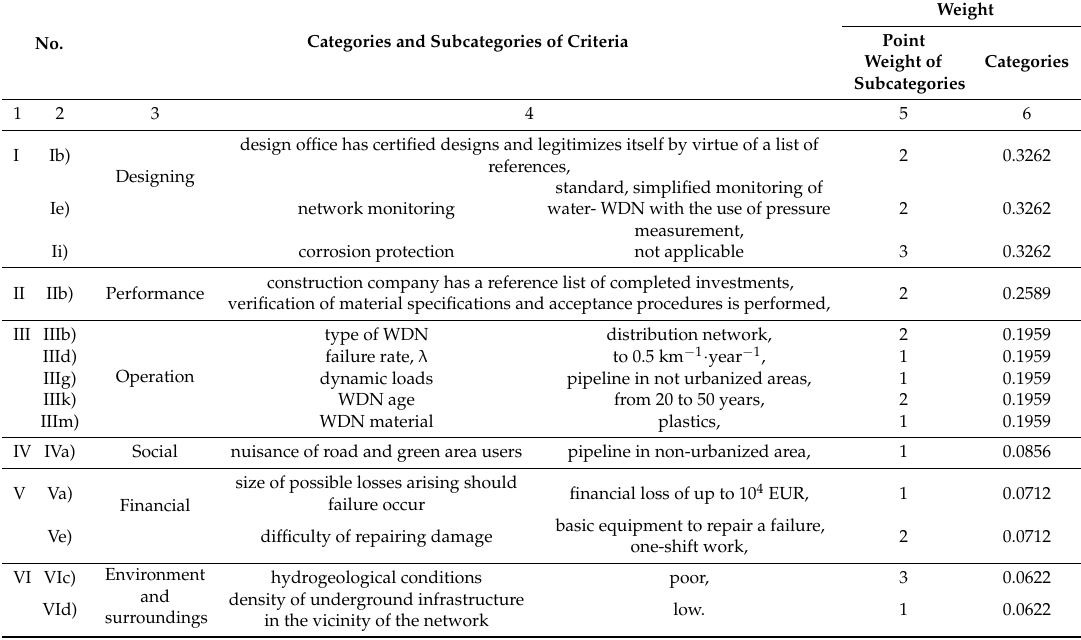
Table 5. A characterisation of the